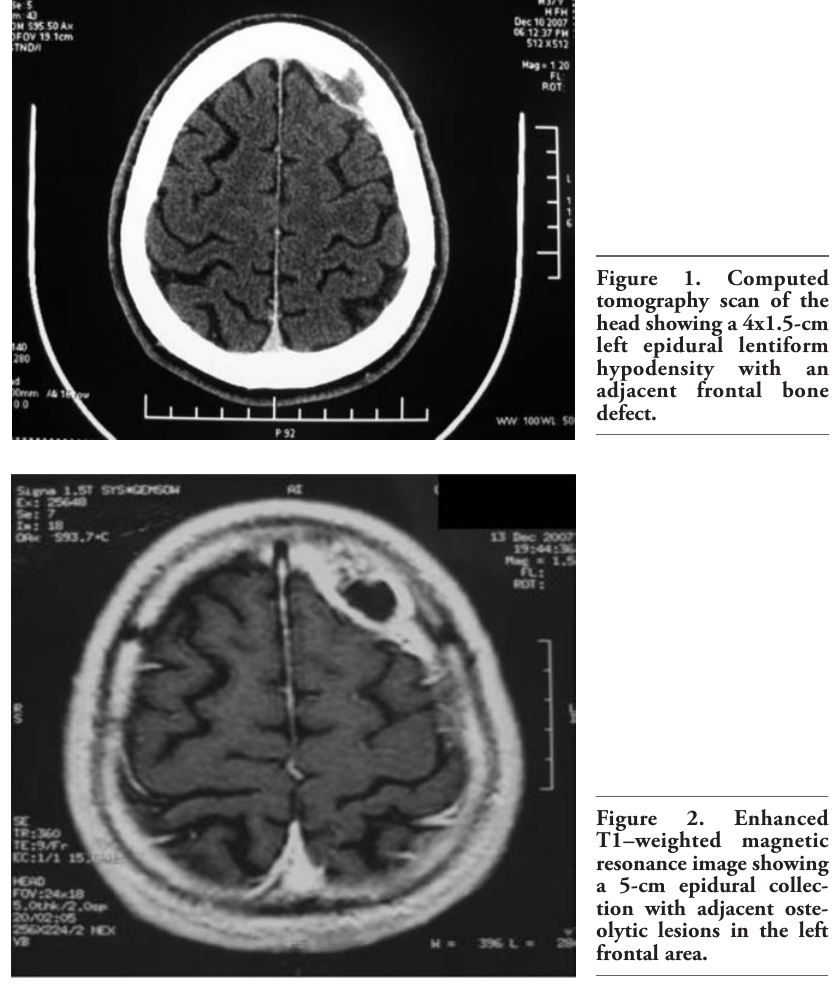
Figure 1. Computed tomography scan of the head showing a 4x1.5-cm left epidural lentiform hypodensity with an adjacent frontal bone defect.